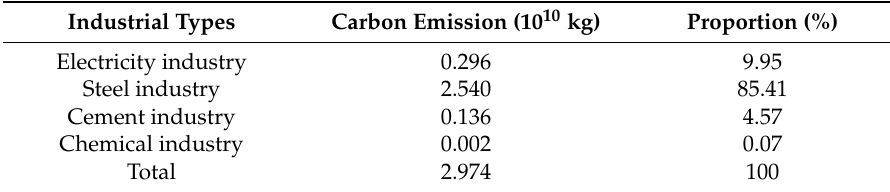
Table 7. Structure of carbon emissions in different industry